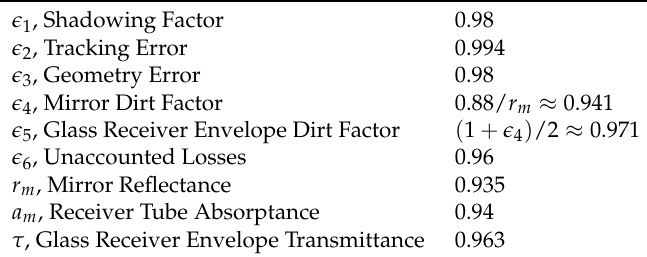
Table A1. The PTC modeling parameters.